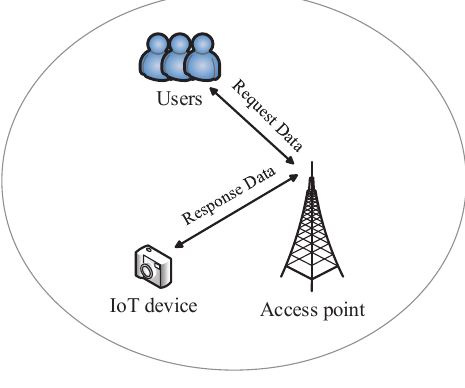
Figure 3. IoT scenario of spectrum